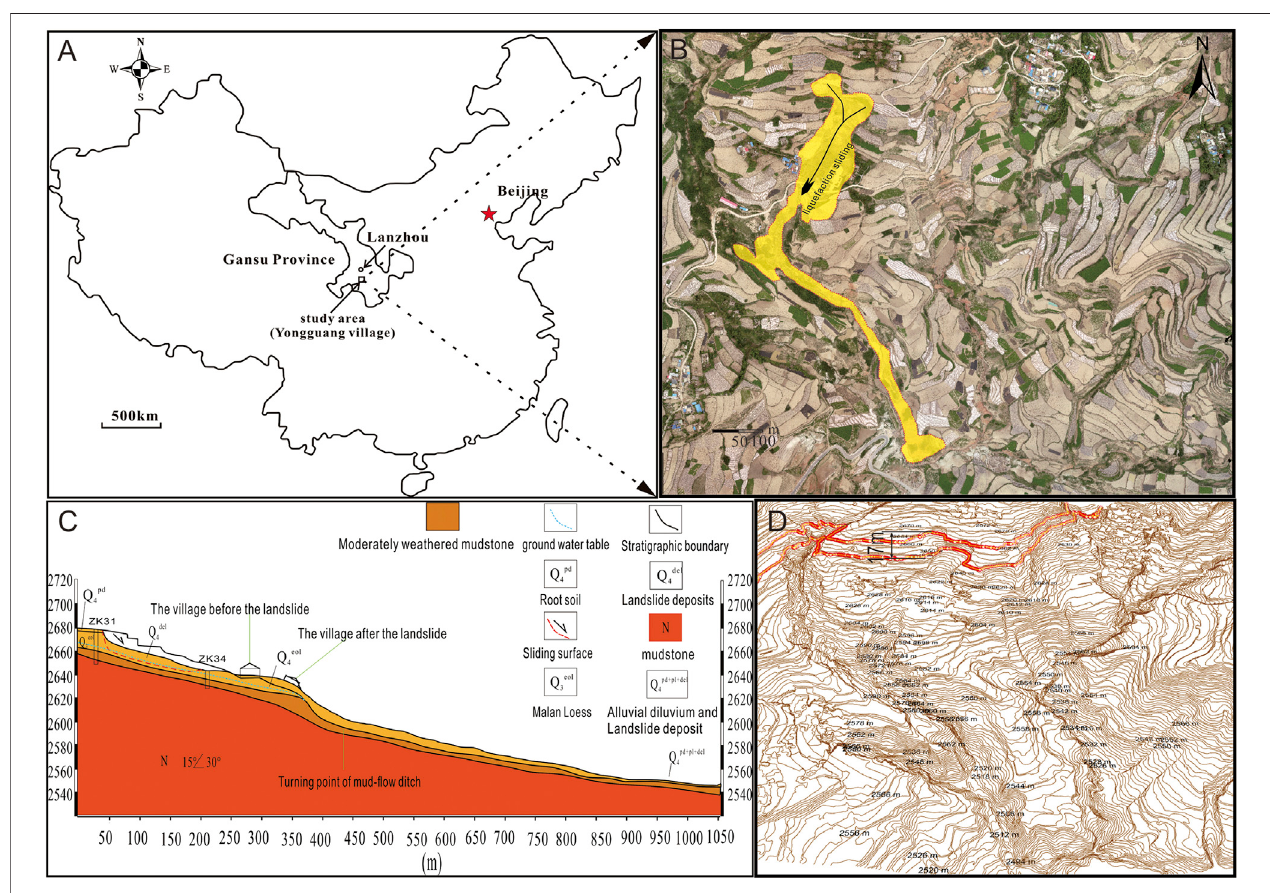
FIGURE1|(A) Location oftheYongguanglandslide; (B) Thelandform afterthelandslide; (C) Theengineeringgeologicalpro fi leoftheYongguangvillagelandslide; (D) The contour line of landslide DSM.